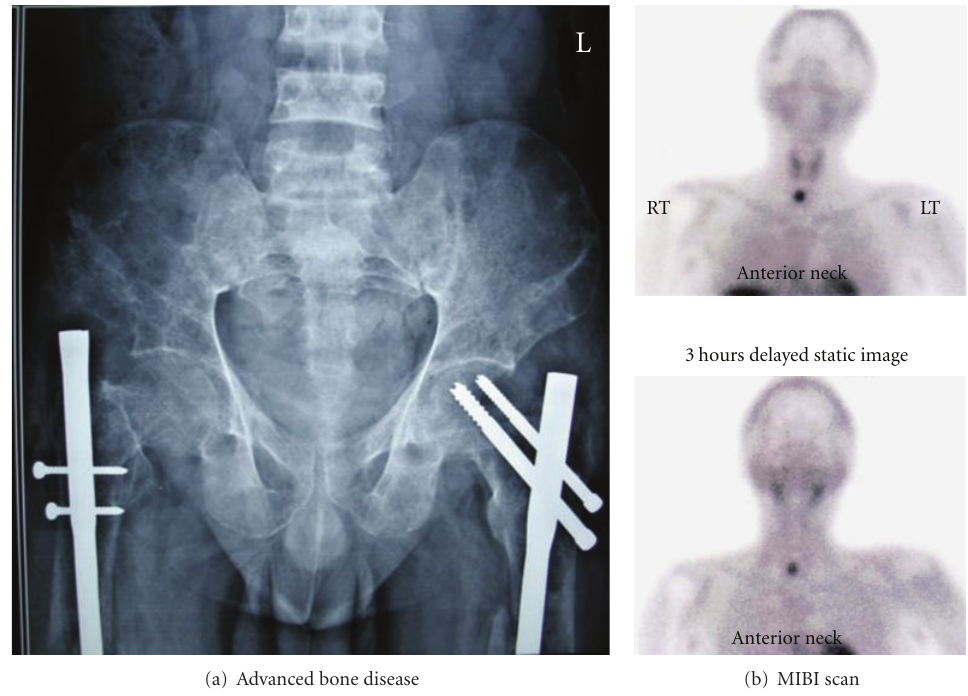
Figure 3: (a) Reveals advanced bone disease with fractures of femur (fixed by rod and nails) and (b) the MIBI scan in a patient with parathyroid adenoma.